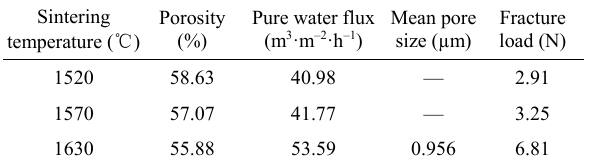
Table 1 Measured properties of pure mullite hollow fiber membranes sintered at different temperatures for 5 h